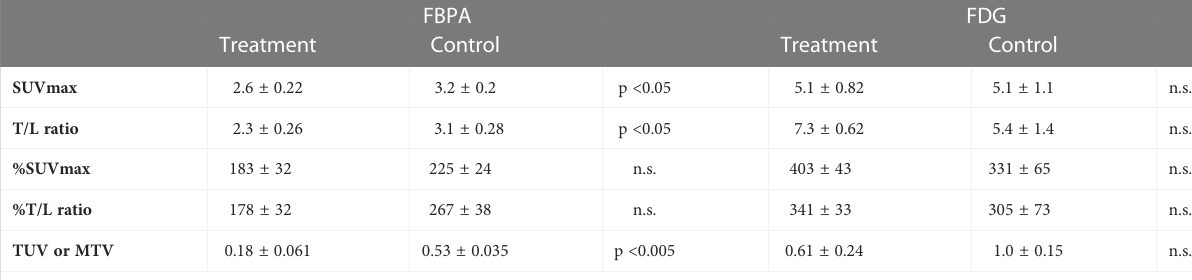
TABLE 1 Comparison of quantitative parameters between the treatment and control groups in PET using FBPA or FDG.